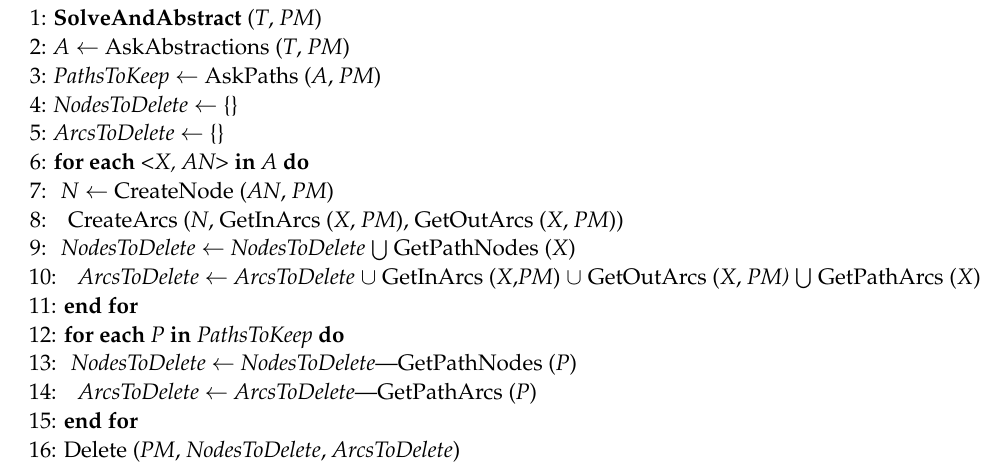
Algorithm 4: pseudocode of the conflict resolution and abstraction